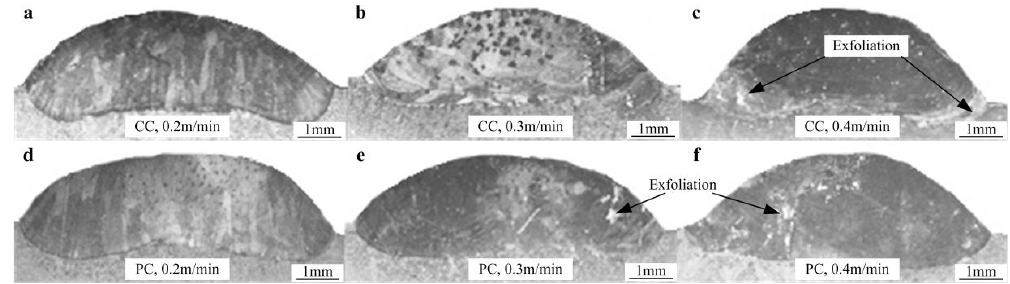
Figure 3. Macro morphology of single bead in different experimental parameters: ( a ) CC 0.2 m/min; ( b ) CC 0.3 m/min; ( c ) CC 0.4 m/min; ( d ) PC 0.2 m/min; ( e ) PC 0.3 m/min; and ( f ) PC 0.4 m/min.